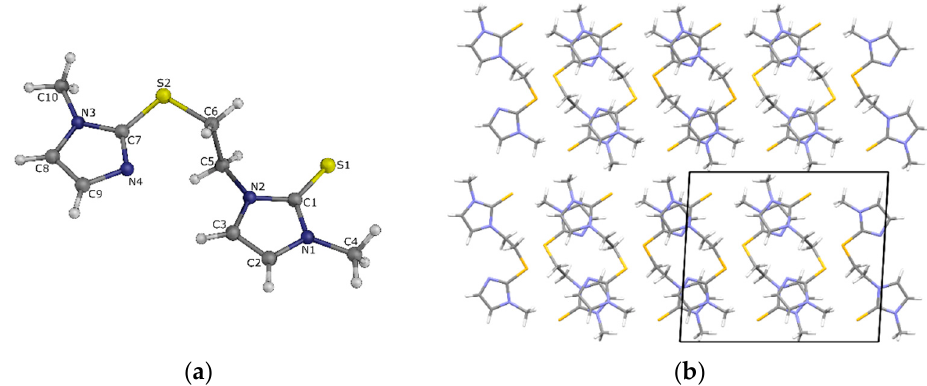
Figure 9. ( a ) Molecular structure of 8 with the atomic numbering scheme; ( b ) projection of 8 down the crystallographic b axis;.